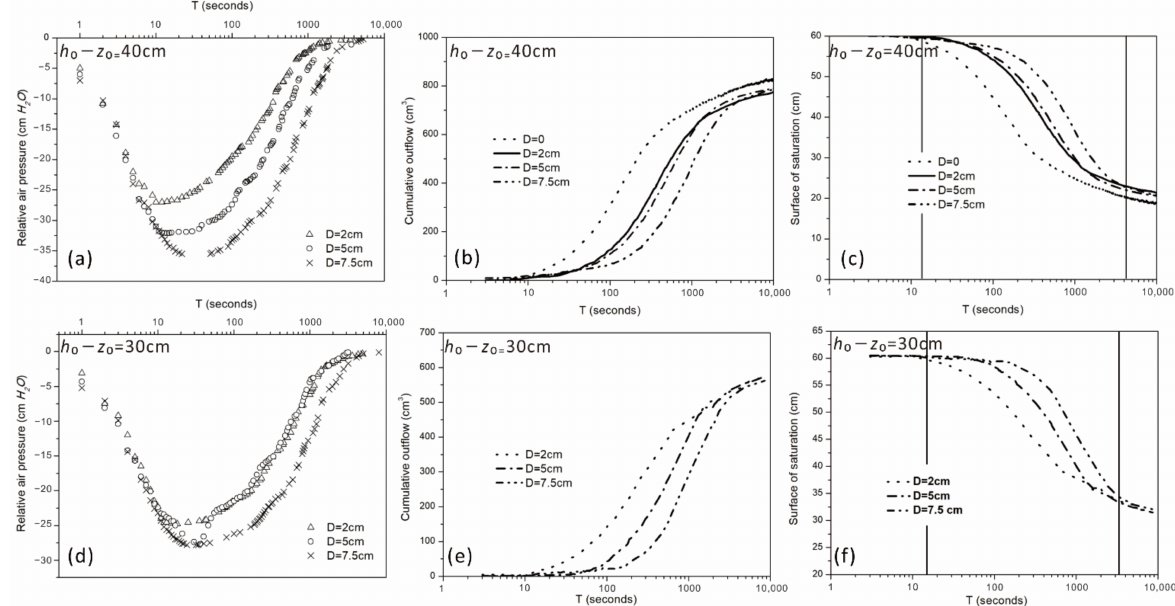
Figure 4. Changes of negative pressure (NP), cumulative outflow, and height of saturation surface with time in drainage experiments. ( a ) Changes of relative air pressure with time in vadose zone ( h 0 − z 0 = 40 cm). ( b ) Changes of cumulative outflow with time ( h 0 − z 0 = 40 cm). ( c ) Changes of calculated height of saturation surface with time ( h 0 − z 0 = 40 cm). ( d ) Changes of relative air pressure with time in vadose zone ( h 0 − z 0 = 30 cm). ( e ) Changes of cumulative outflow with time ( h 0 − z 0 = 30 cm). ( f ) Changes of calculated height of saturation surface with time ( h 0 − z 0 = 30 cm). In ( c , f ) the vertical lines subdivide the early, middle, and late